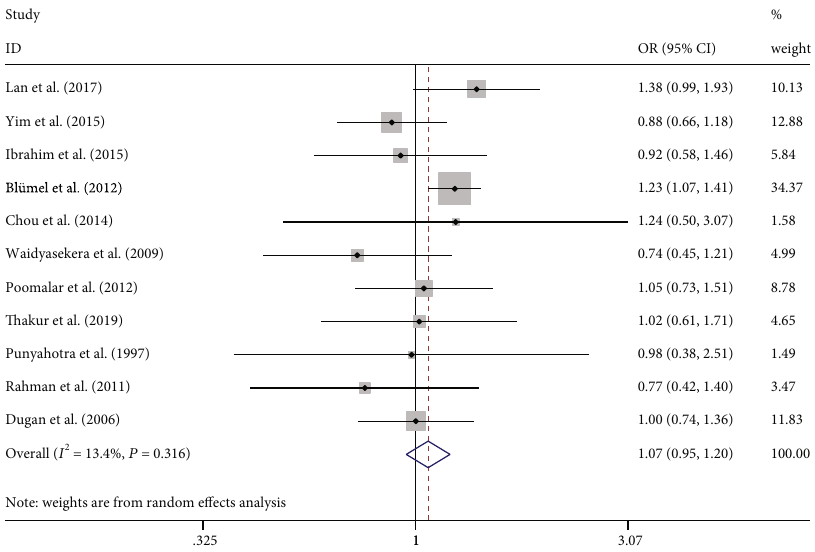
Figure 4: Meta-analysis of the prevalence estimates of MSP between perimenopausal and postmenopausal women. Eleven studies were included in the analysis. OR (95% CI): odds ratio (95% con fi dence interval).